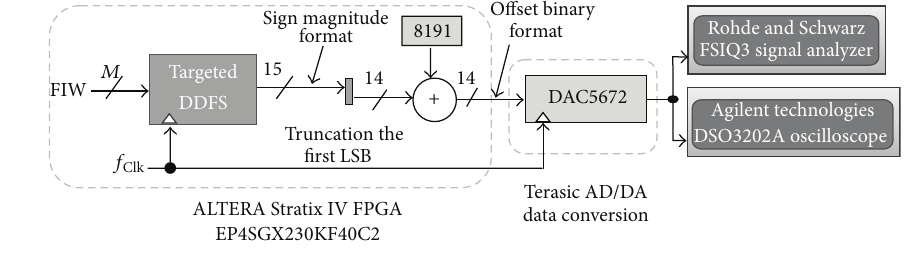
Figure 18: The proposed DDFS under test.